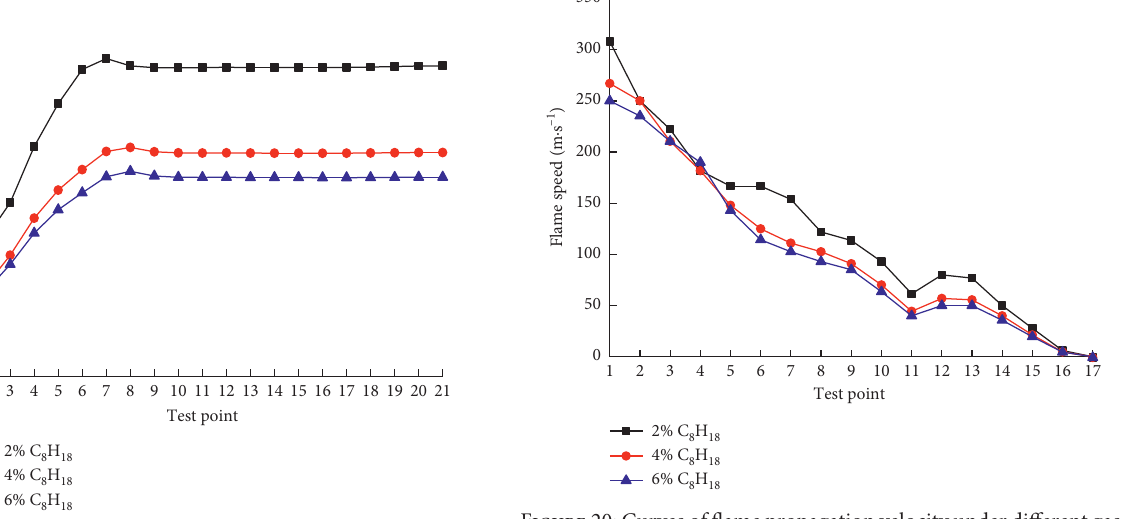
Figure 18: Curves of peak pressure under different gas